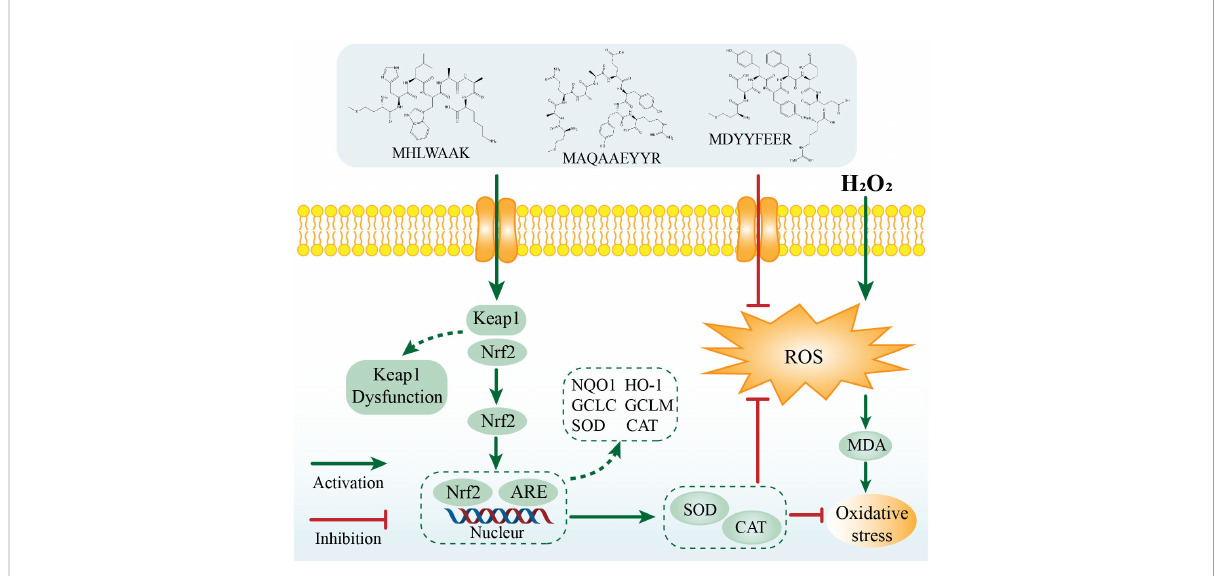
FIGURE 8 The possible molecular mechanism for the protective effects of three novel antioxidant peptides against H 2 O 2 -induced oxidative